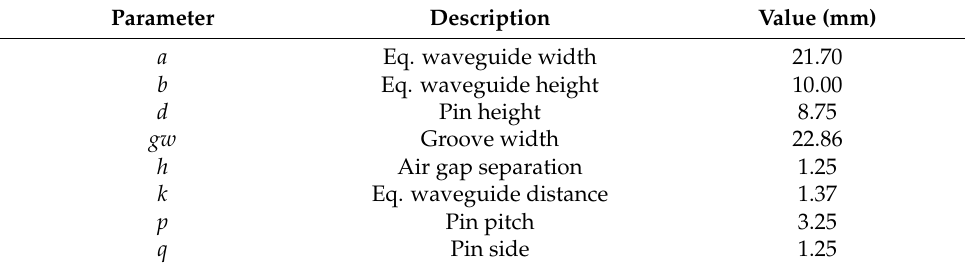
Table 1. Groove gap waveguide geometrical parameters.